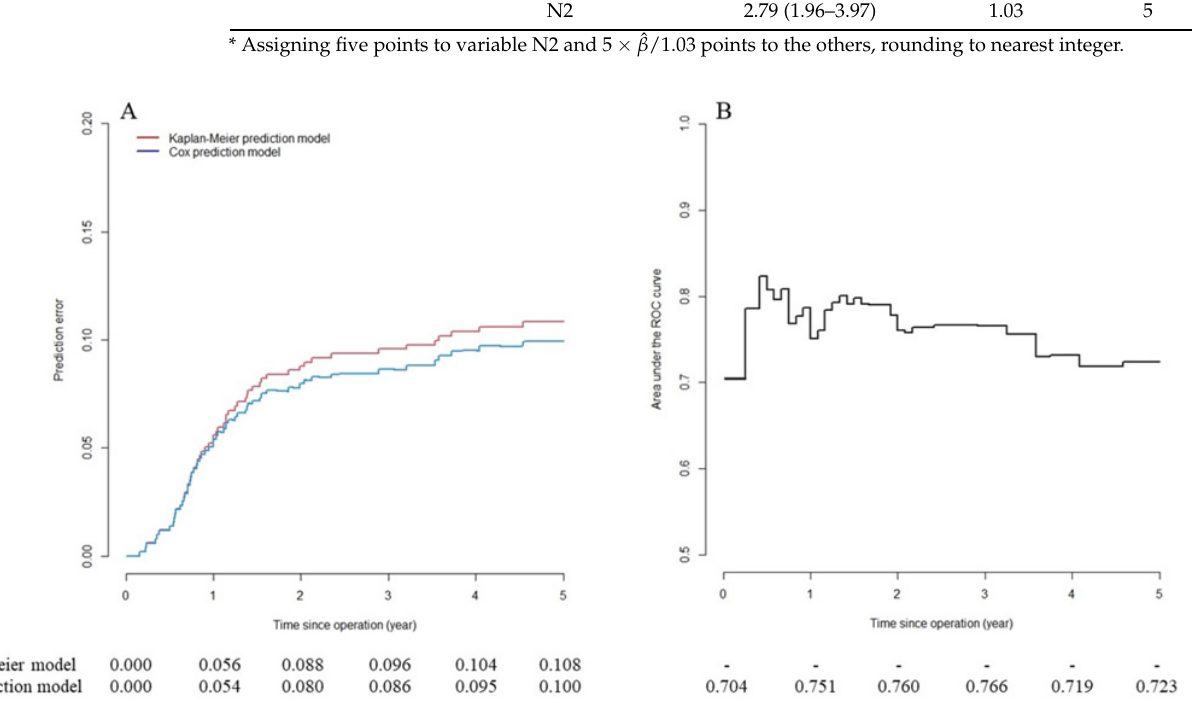
Figure 1. Long-term predictive performance of metachronous peritoneal carcinomatosis (mPC) risk prediction model in testing set. ( A ) Predictive error curve. mPC risk prediction model has high predictive accuracy (prediction error ≤ 5%) within one year of operation. After that, predictive accuracy decreases gradually but continues to be better compared to Kaplan–Meier model (no factors included). ( B ) Time-dependent area under the curve (AUC) of mPC risk prediction model shows acceptable discrimination ability (0.7 ≤ AUC ≤ 0.8) six months after operation. Table 3. Prediction model of metachronous peritoneal carcinomatosis risk and scoring system based on training set (N = 1503).